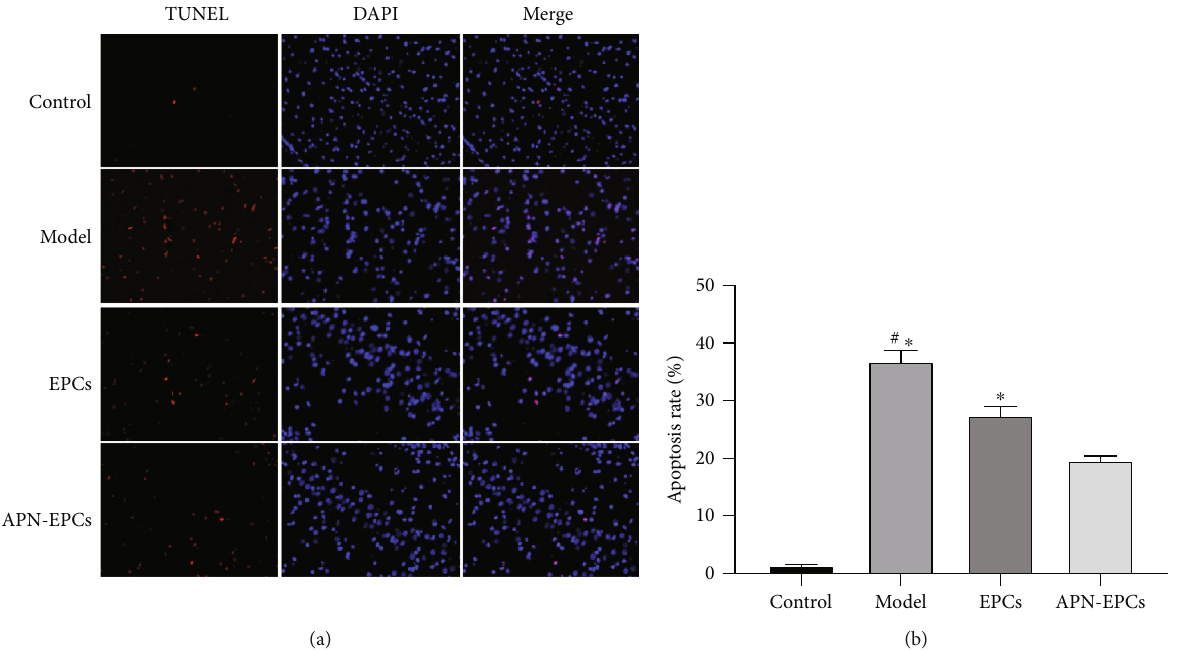
Figure 8: In fl uence of APN-EPC treatment on apoptosis rate. (a). TUNEL/DAPI immuno fl uorescence staining (x400). (b). Cell apoptosis rate. ∗ p < 0 : 05 the model group or the EPC group compared with the APN-EPC group, # p < 0 : 05 the model group compare with the control group.